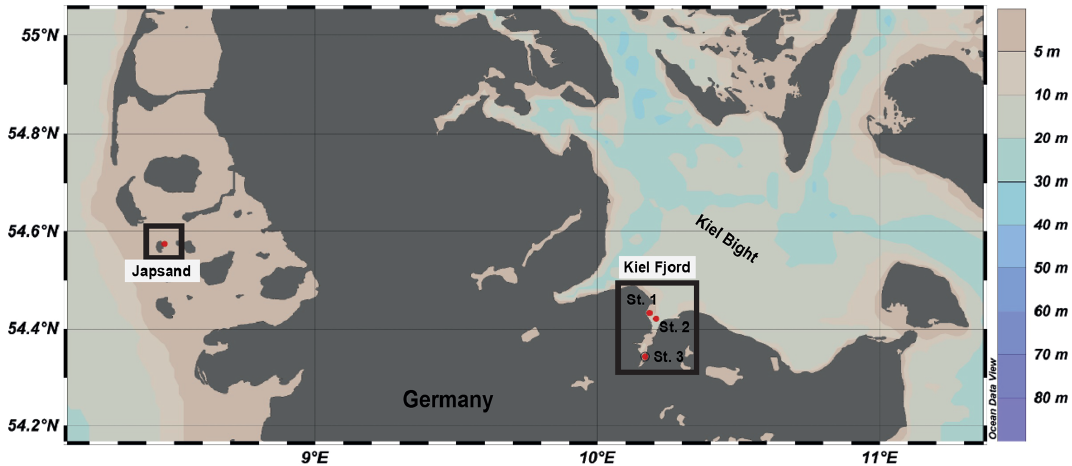
Figure 1. Location of the sampling stations in the North Sea (Japsand area) and in the Baltic Sea (Kiel Fjord, St. 1 Strander Bucht, St. 2 Laboe, St. 3 Mönkeberg). The map was drawn with Ocean Data View (Schlitzer, 2016) on the basis of bathymetric data. Water depths in metres are indicated by the colour